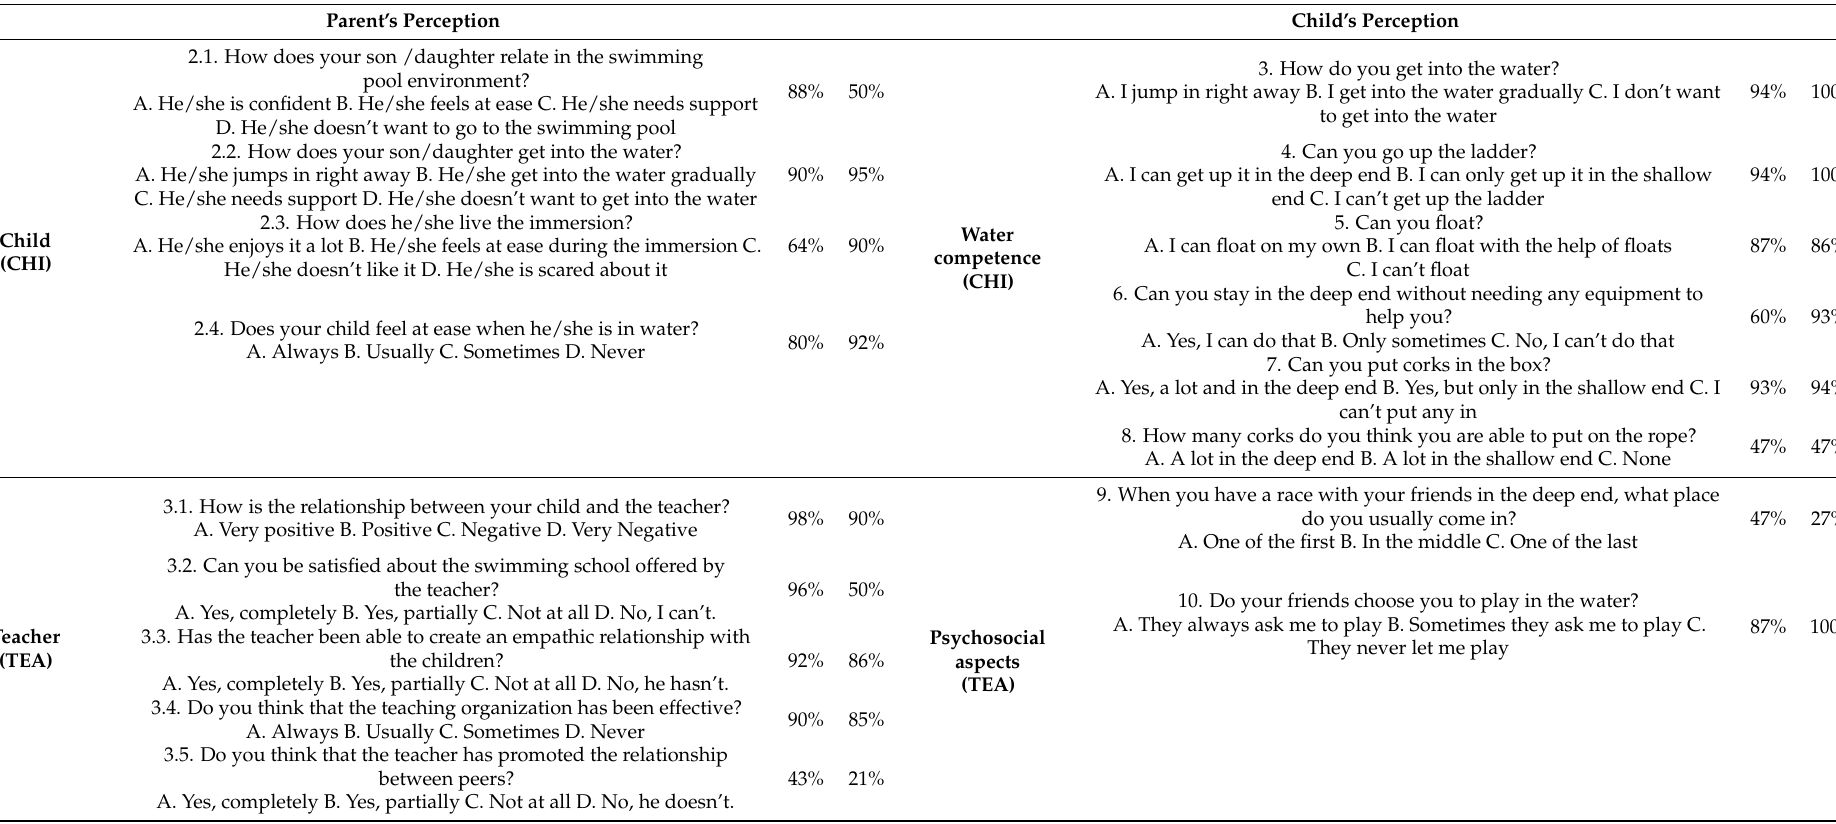
Table 3. Cont. Percentage Data Are Shown below (Table 3).